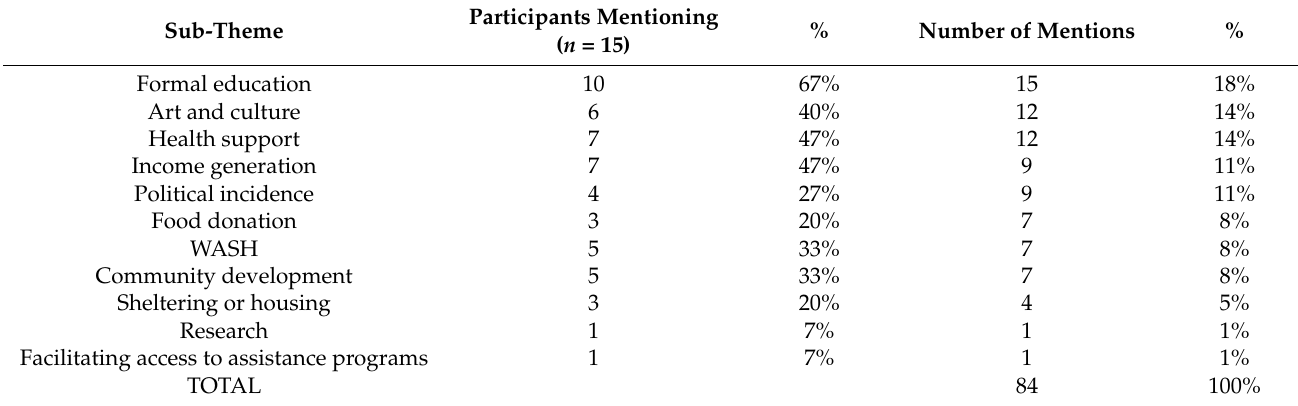
Table 4. CSO initiatives before the COVID-19 pandemic.